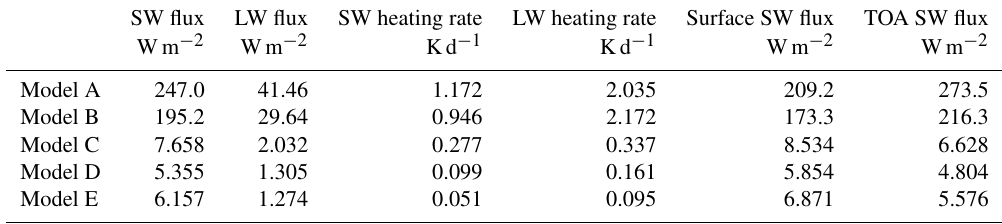
Table 2. RMSE of different ML-based radiation emulators for test data in offline evaluation.